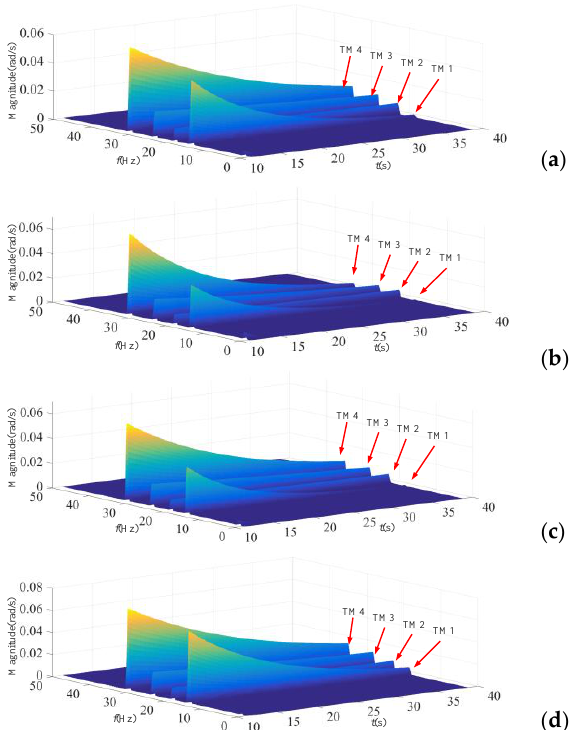
Figure 14. Rotor speed response of SG and the time–frequency analysis result: ( a ) K p =1 p.u; ( b ) K p = 10 p.u; ( c ) v = 4 m/s; (d) v = 7 m/s .